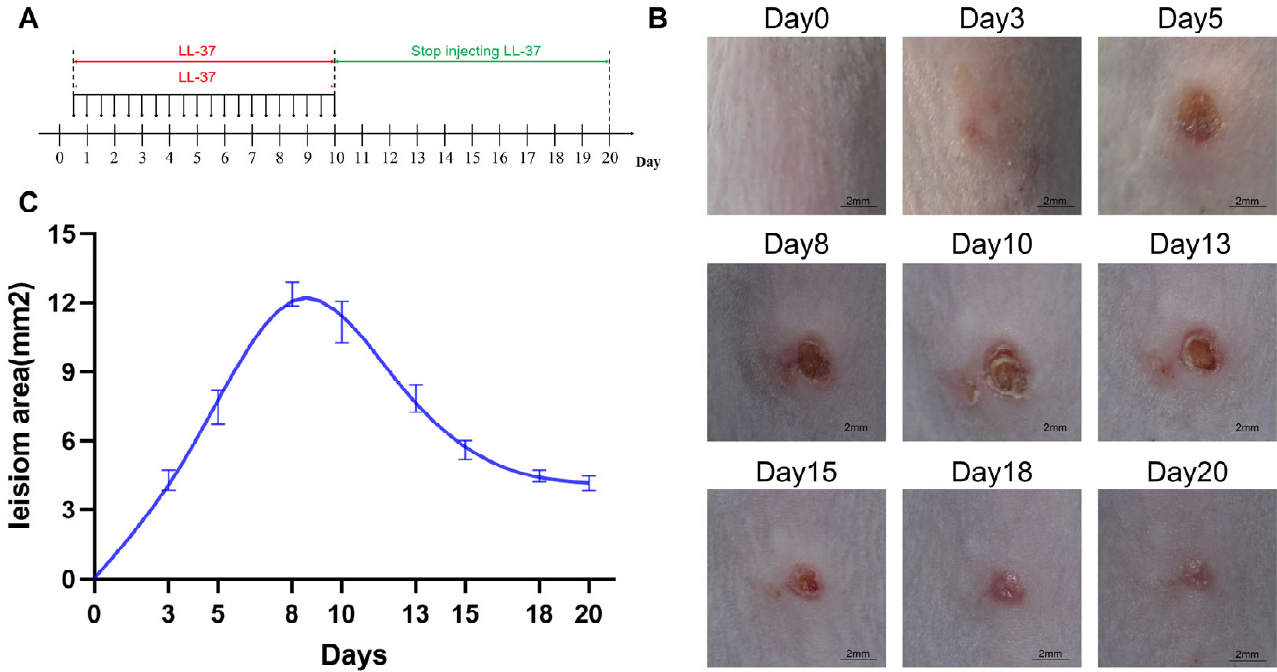
Figure 7. ( A ) The long-term LL-37 administration and self-recovery group received intradermal injections of LL-37 every 12 h for 10 days before being euthanized on days 0, 10, and 20. ( B ) LL-37 intradermal injections were stopped after 10 days, and erythema changes in the lesion areas of mice on days 0, 3, 5, 8, 10, 13, 15, 18, and 20 from the first injection were recorded (scale bar = 2 mm). ( C ) Trend plot of lesion area. With the extension of LL-37 injection time, the erythema area gradually expanded, and after stopping the injections, the erythema area stabilized after returning to a certain level on the 18th day but did not fully recover. Data are presented as the mean ± SD; n = 5 for each group.